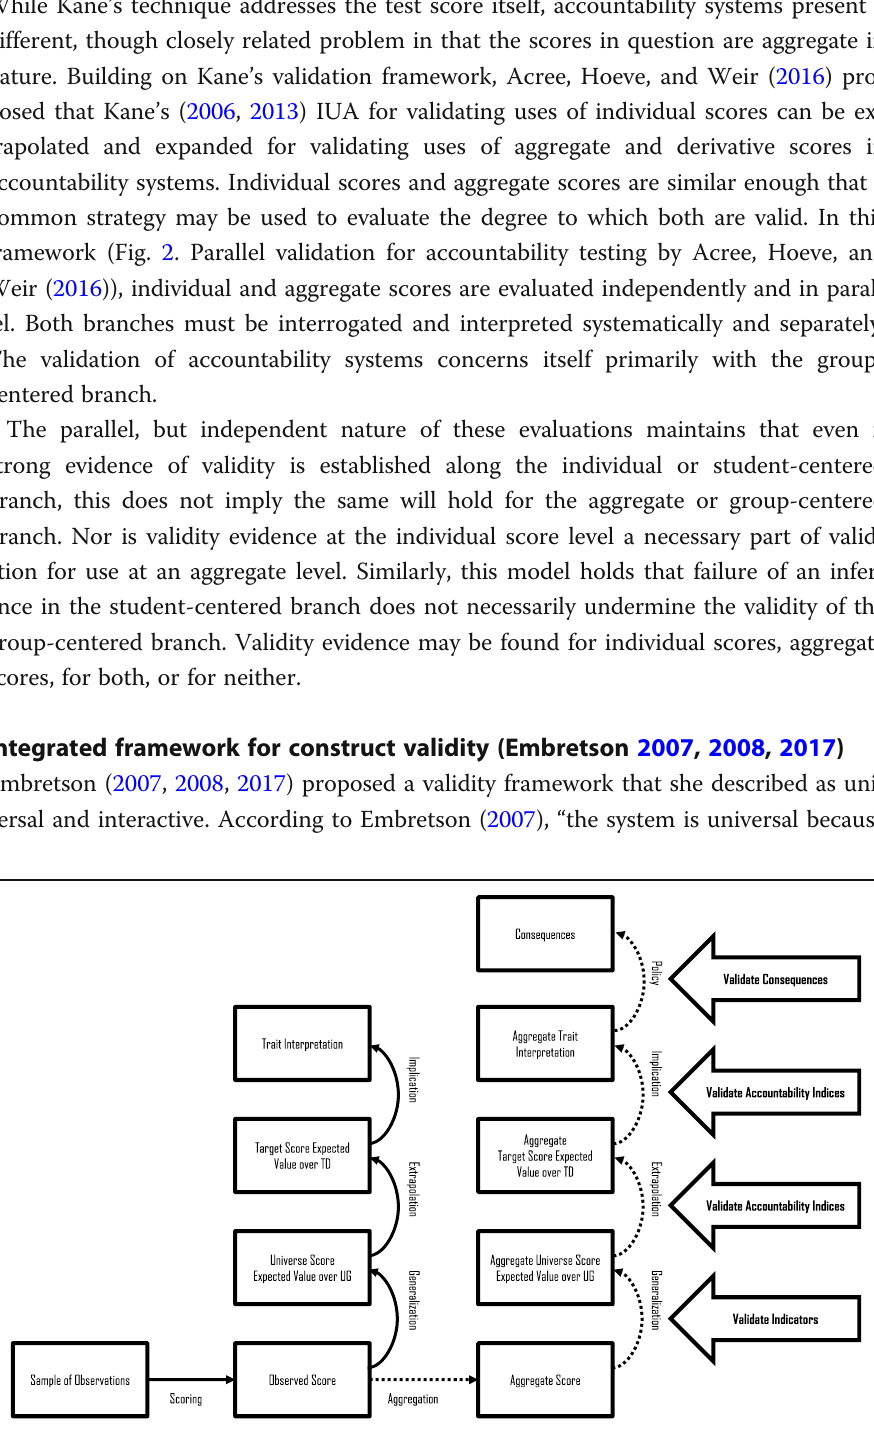
Fig. 2 Parallel validation for accountability testing by Acree, Hoeve, and Weir